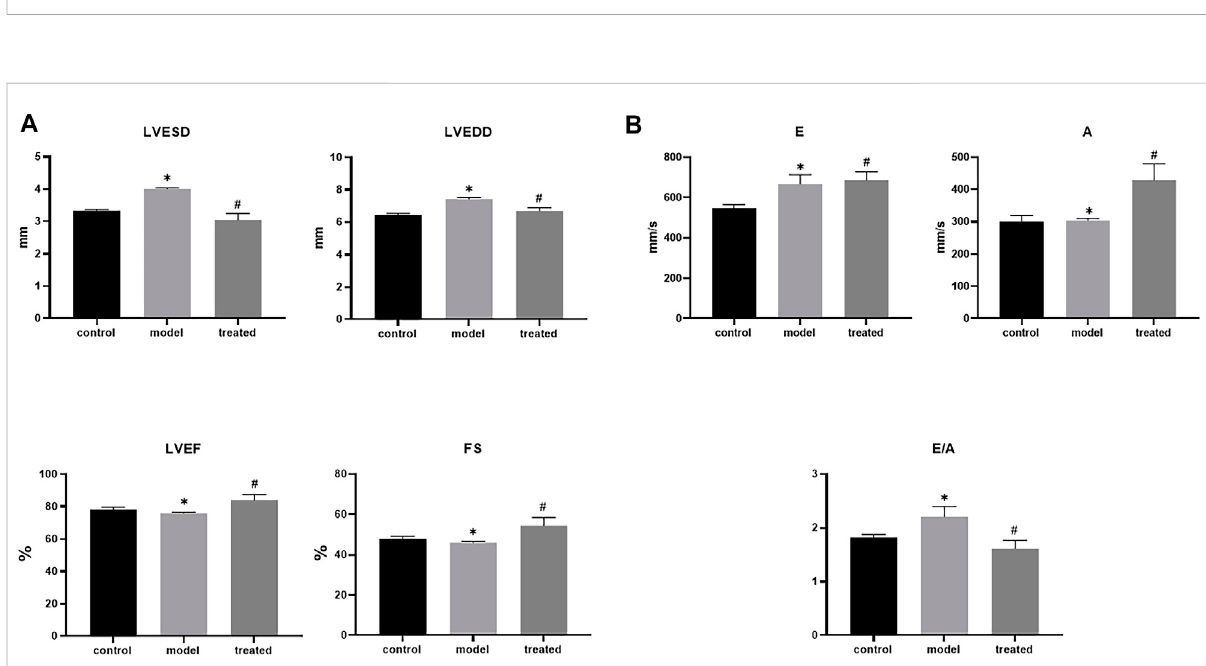
FIGURE 10 Each group left ventricular end-systolic diameter (LVESD), left ventricular end-diastolic diameter (LVEDD), Fractional shortening (FS), left ventricularejectionfraction(LVEF). (A) ;earlydiastole(E),latediastole(A)andE/Aofratsineachgroup (B) ,Dataareshownbymean±SEM(n=8).* p < 0.05 vs. control group; # p < 0.05 vs. model